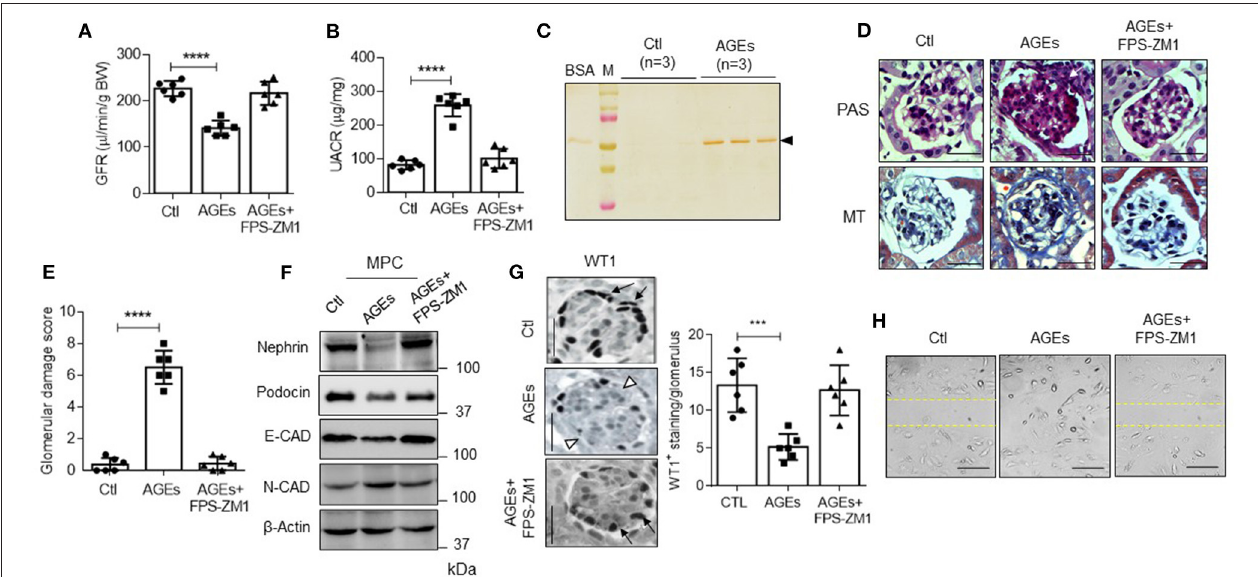
FIGURE 5 | (A) GFR and (B) UACR in control (Ctl) and AGEs administered mice ( n = 6). **** p < 0.0001. (C) Urinary samples from Ctl and AGEs administered mice were subjected to SDS-PAGE and silver-stained as described under “Experimental Procedures.” BSA was used as a standard. M = standard protein marker. (D) PAS and MT staining in glomeruli from with or without AGEs and AGEs + FPS-ZM1 treated mice ( n = 6). Magnification (x 630). Scale bars indicate 20 µ m. (E) Glomerular damage score was derived from PAS-stained images by summing the glomerular capillary blockage (white asterisk) and adhesion of glomerular tuft to Bowman’s capsule (white arrow). Each data point represents the average value of 20 glomeruli from a single animal from each group ( n = 6). **** p < 0.0001. (F) Immunoblotting analysis for nephrin, podocin, E-CAD, N-CAD, and β -Actin in mice podocytes (MPC) from with or without and AGEs administered mice ( n = 6). (G) Staining for WT1 (podocyte) in glomerulus from mice from each group (Ctl, AGEs, and AGEs + FPS-ZM1). Magnification (x 630). Scale bar indicates 20 µ m. The black arrow indicates the podocytes, and the white arrowhead indicates the loss of podocytes in the glomerulus (Left). An average number of WT1 positive ( + ) cells from 20 glomeruli from each group (Right). *** p < 0.001. (H) A wound-healing assay was performed to determine the extent of human podocyte motility from Ctl, AGEs, and AGEs + FPS-ZM1 treatment. Images were captured after 0–12h treatment using an Olympus inverted microscope. Magnification (x 100). Scale bar indicates 100 µ